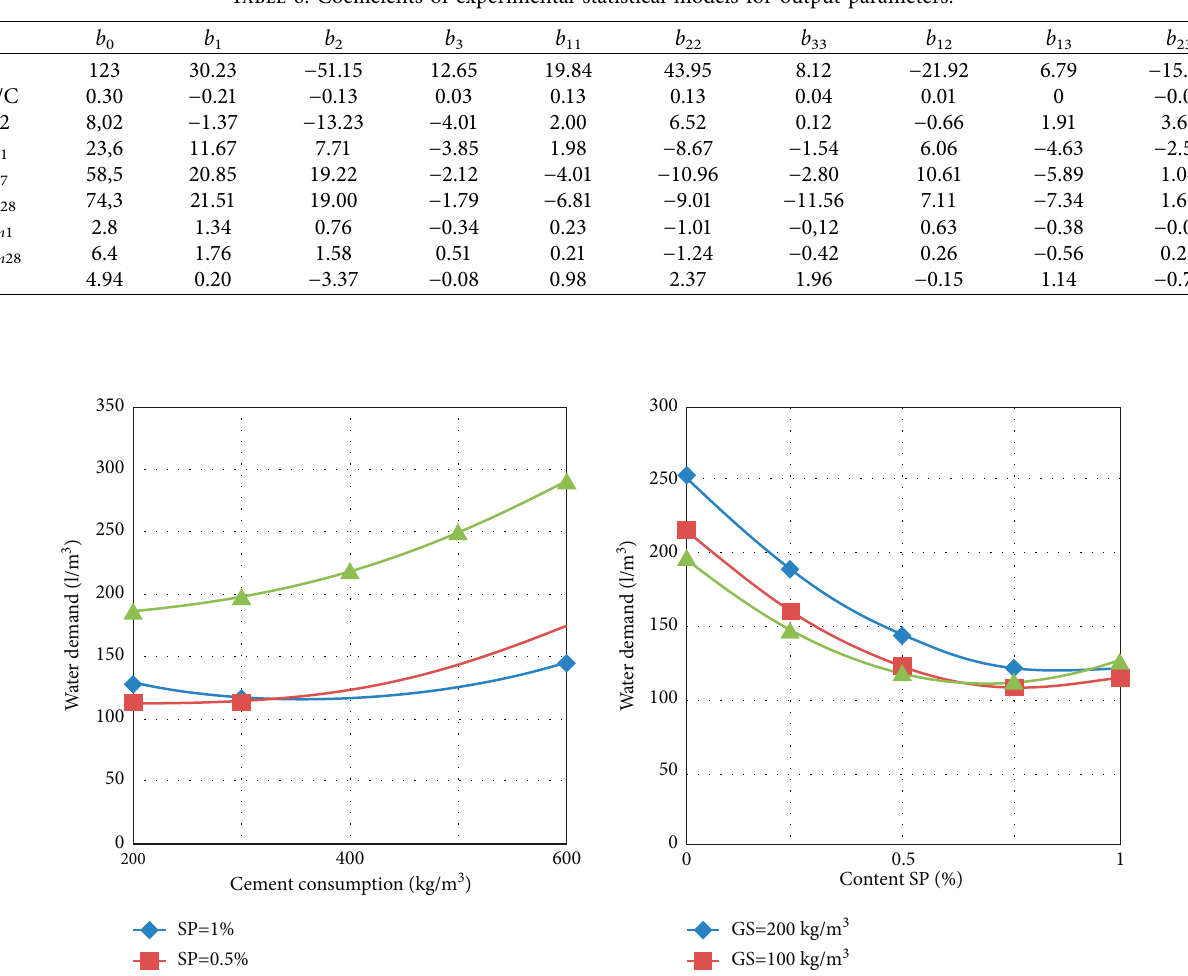
Table 6: Coefficients of experimental-statistical models for output parameters.